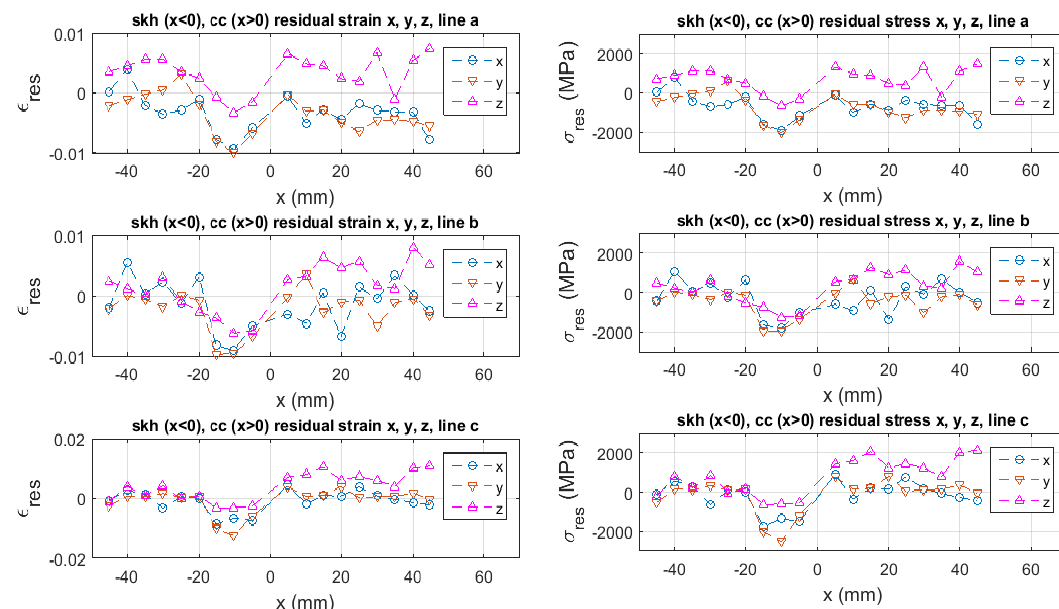
Figure 8. Residual strain based on relative acoustic velocity on Figure 7 and Equation (4), and corresponding residual stress evaluated with Equation